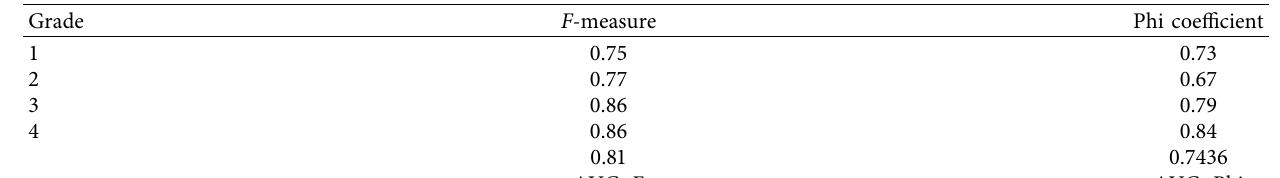
Table 9: Performance evaluation results of the deep network model.